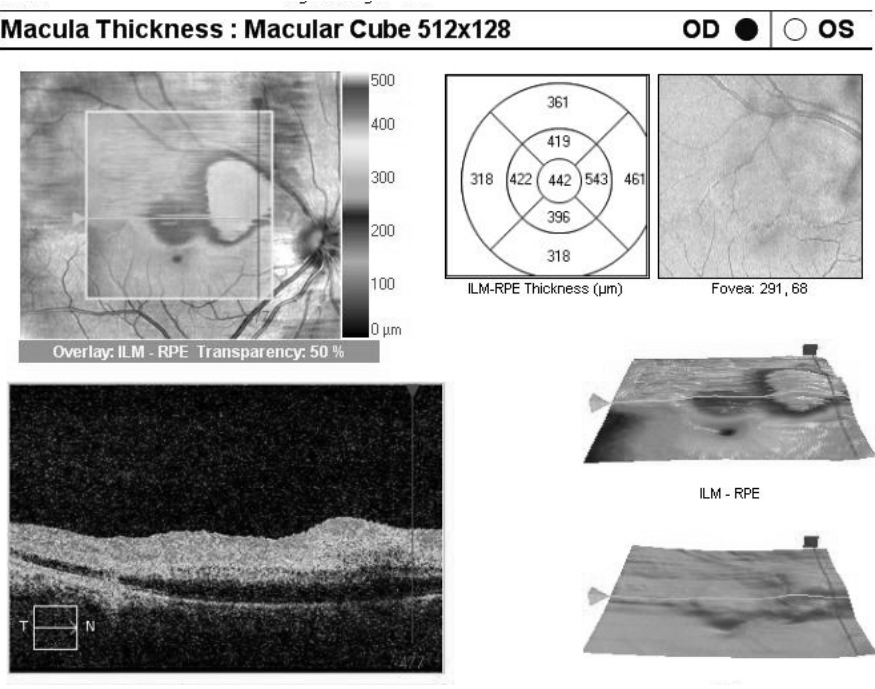
Fig. 3. Right eye. OCT shows thickening associated with hyper-reflectivity of the inner retina with shadowing of the photoreceptor and retinal pigment epithelial layer.